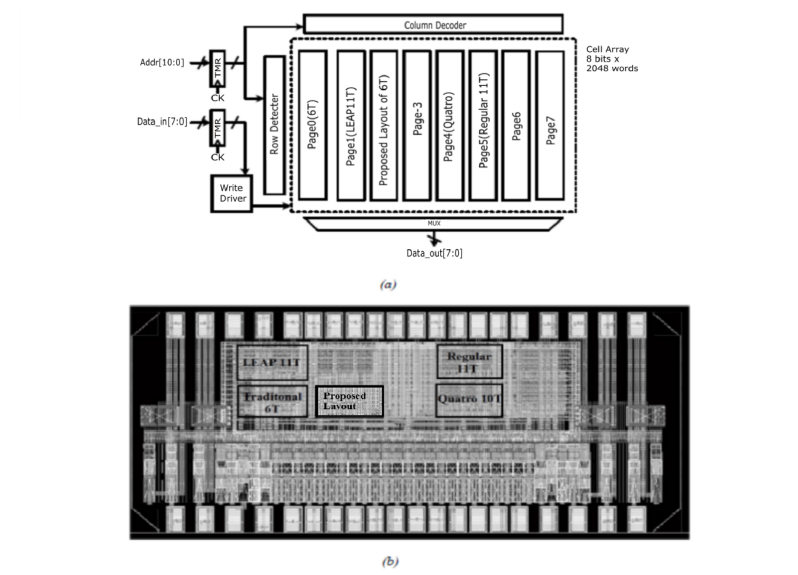
Figure 5. ( a ) Block diagram of SRAM chip; ( b ) die image of SRAM